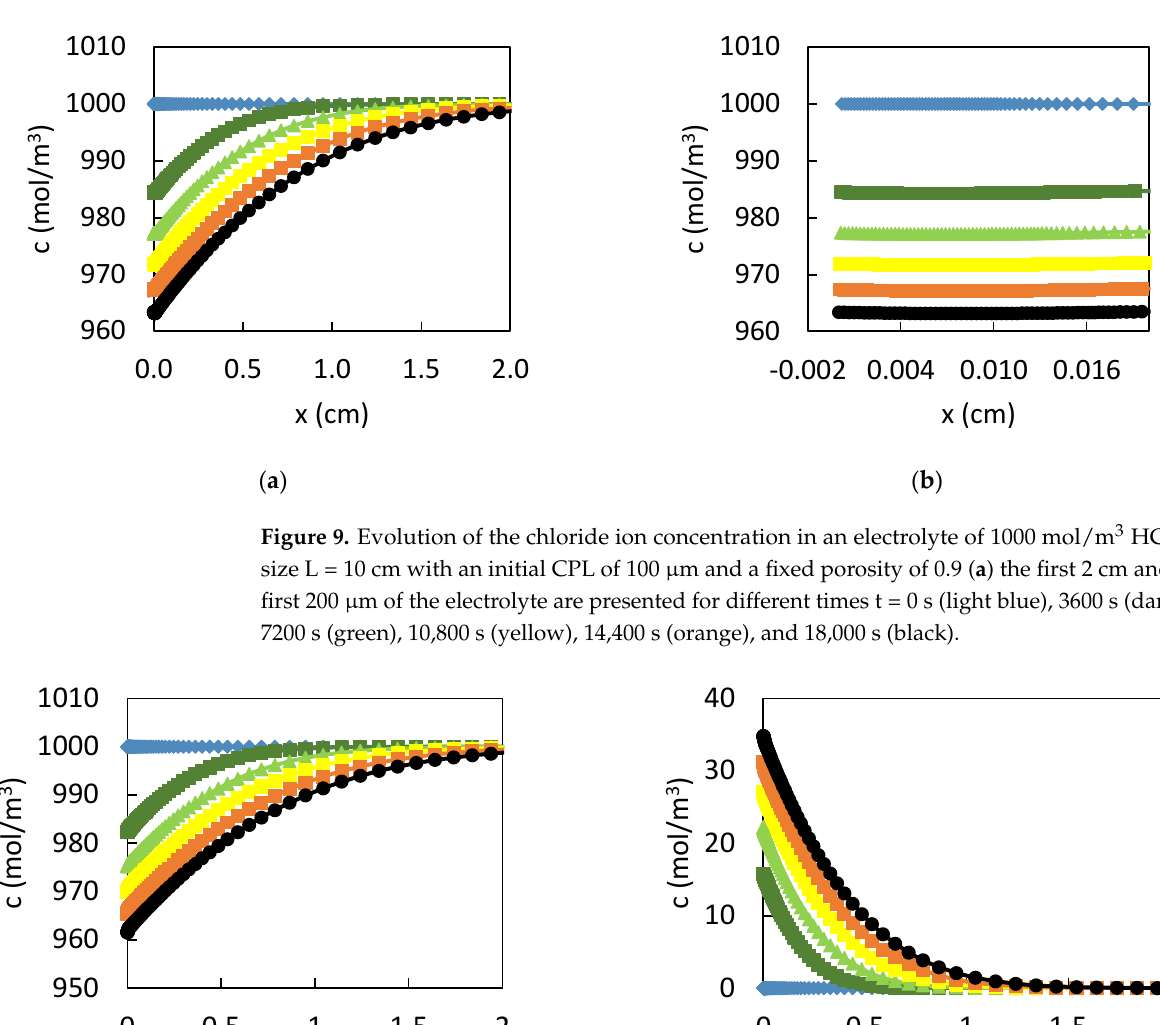
Figure 8. Evolution of the lead ion concentration in an electrolyte of 1000 mol/m 3 HCl and of size L = 10 cm with an initial CPL of 100 µm and a fixed porosity of 0.9 ( a ) The first 2 cm and ( b ) the first 200 µm of the electrolyte are presented for different times t = 0 (light blue), 3600 (dark green) 7200s (green), 10,800 s (yellow), 14,400 s (orange), and 18,000 s (black).